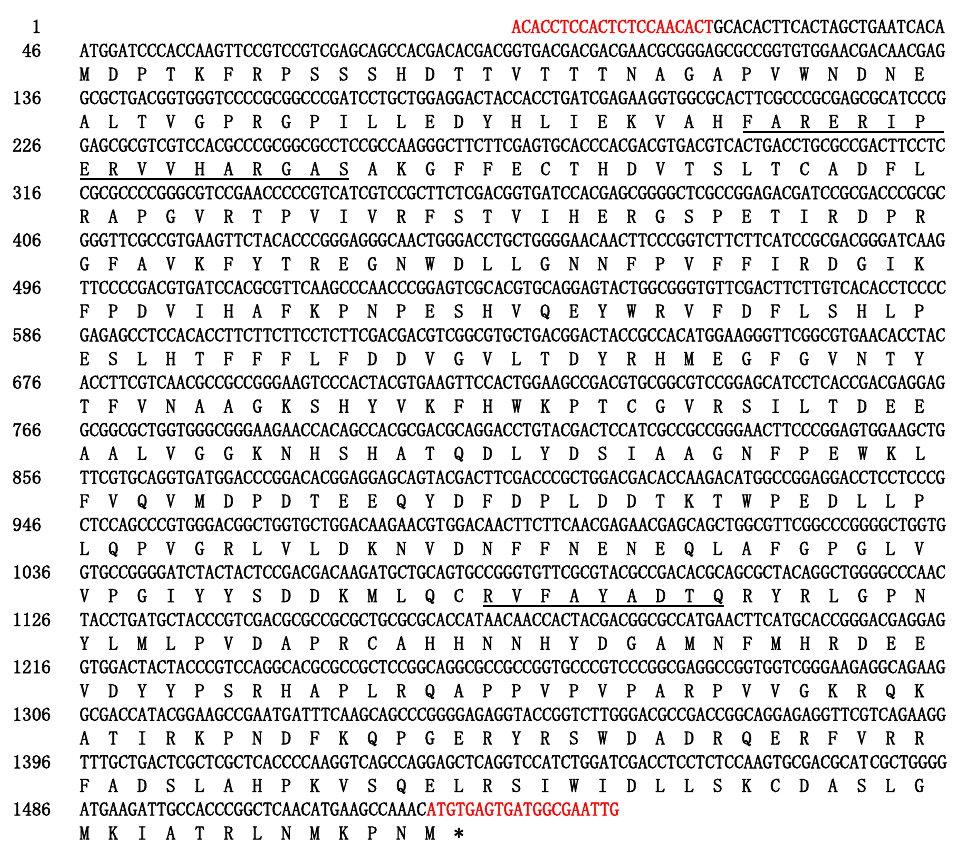
Figure 1. Nucleotide acid sequence and the deduced amino acid sequence of ScCAT2 . Red letters represented the specific amplification primer pair for ScCAT2 . Catalase active site (FARERIPERVVHARGAS) and heme-ligand (RVFAYADTQ) signatures of ScCAT2 were underlined. * represented stop codon.